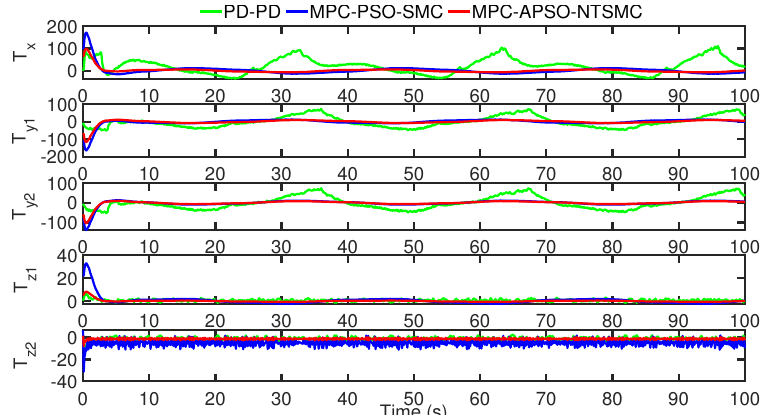
Figure 15. The thrust of thrusters for the tracking task with random disturbance for Case 1.